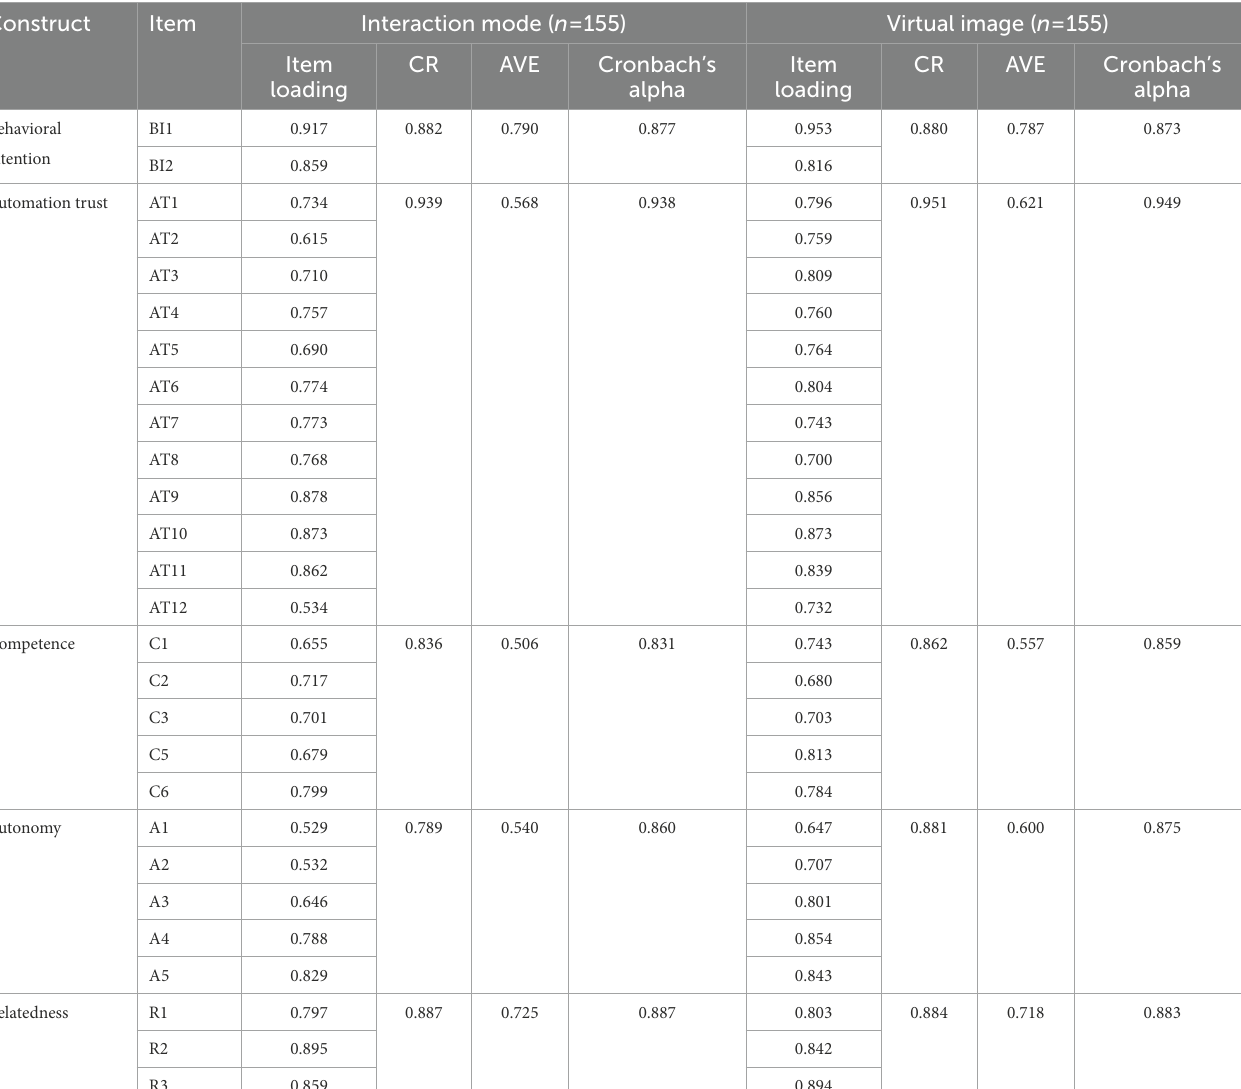
TABLE 5 Standardized factor loadings, AVE, CR and Cronbach’s alpha for the core variable